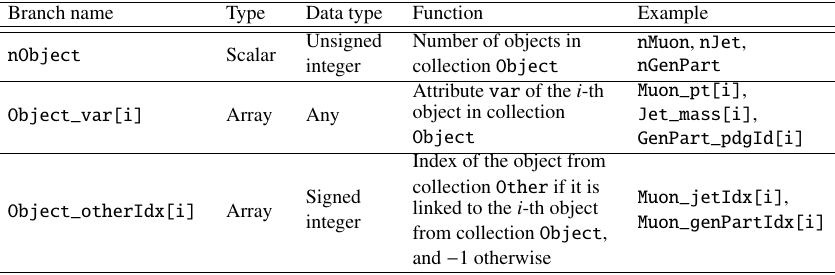
Table 1. Naming convention of object collections established in the NANOAOD format. The rows corresponds to branches in the TTree that is associated with the event content. Object attributes can have any of the following data types: signed or unsigned integer, float or